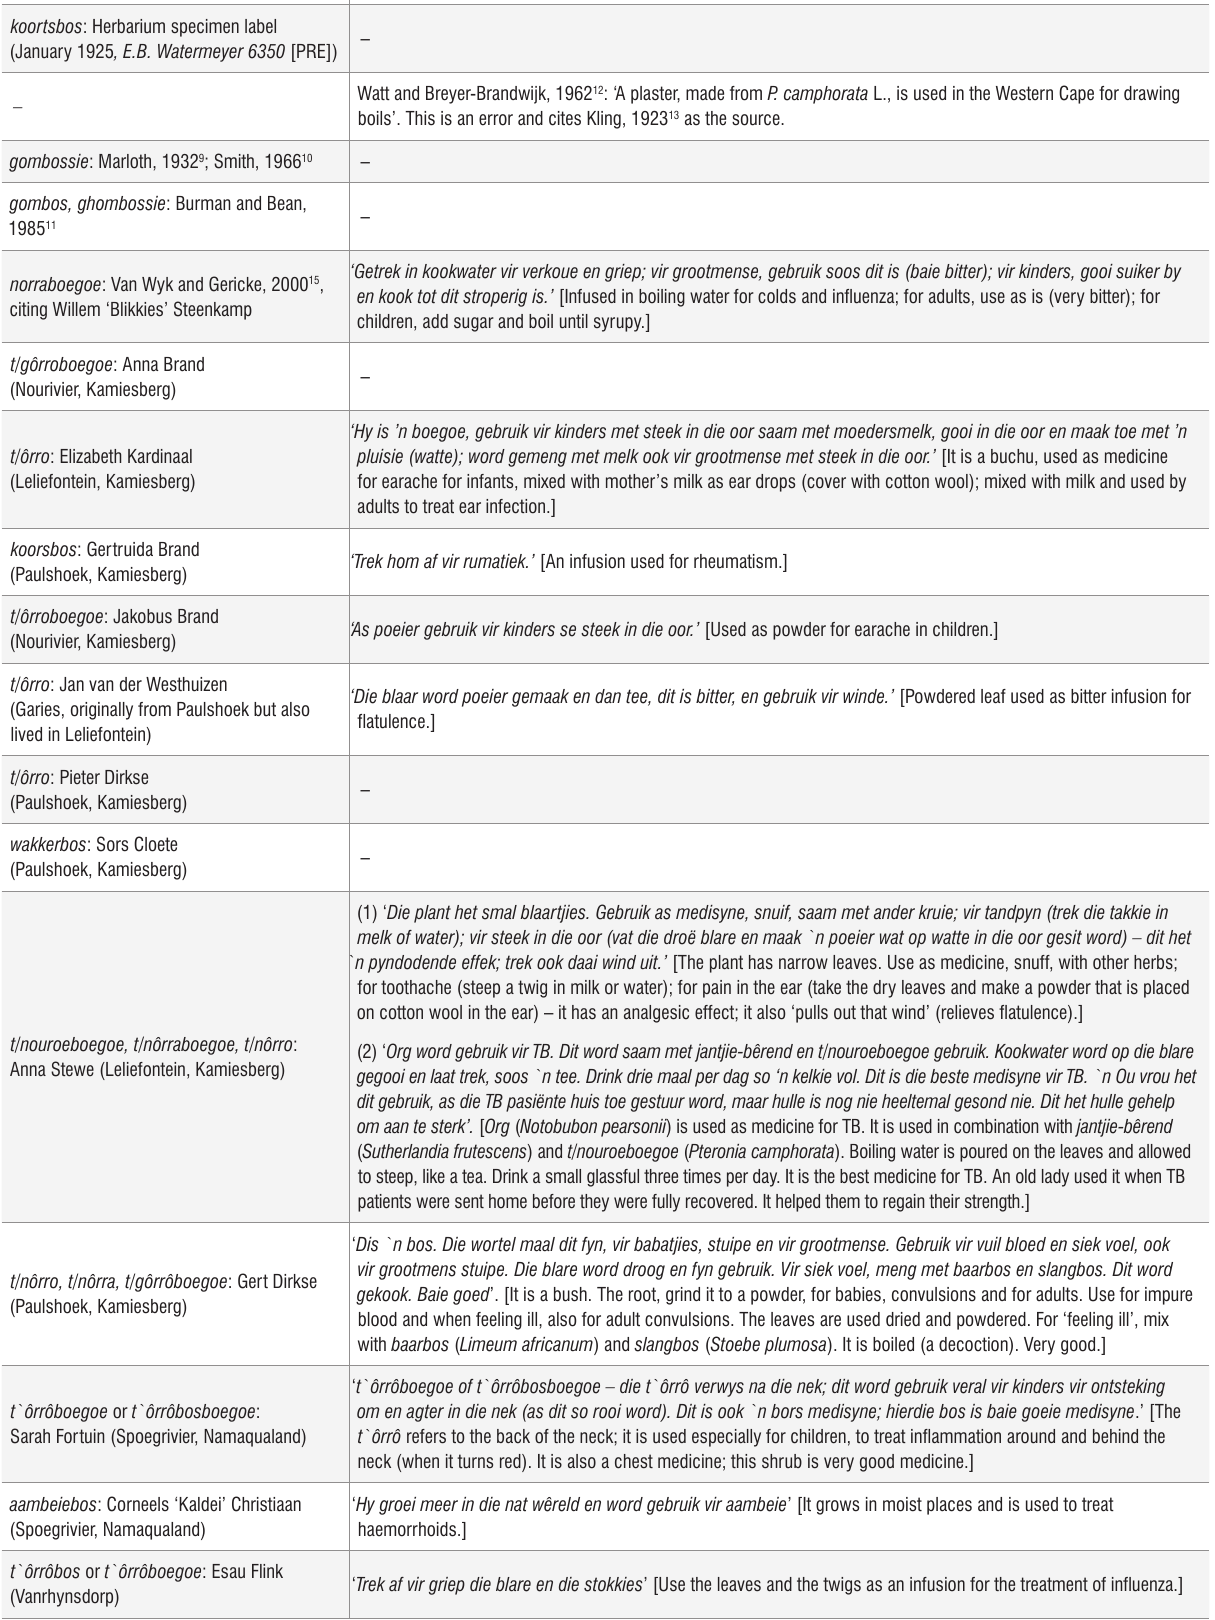
Summary of vernacular names and ethnobotanical anecdotes for Pteronia camphorata Vernacular